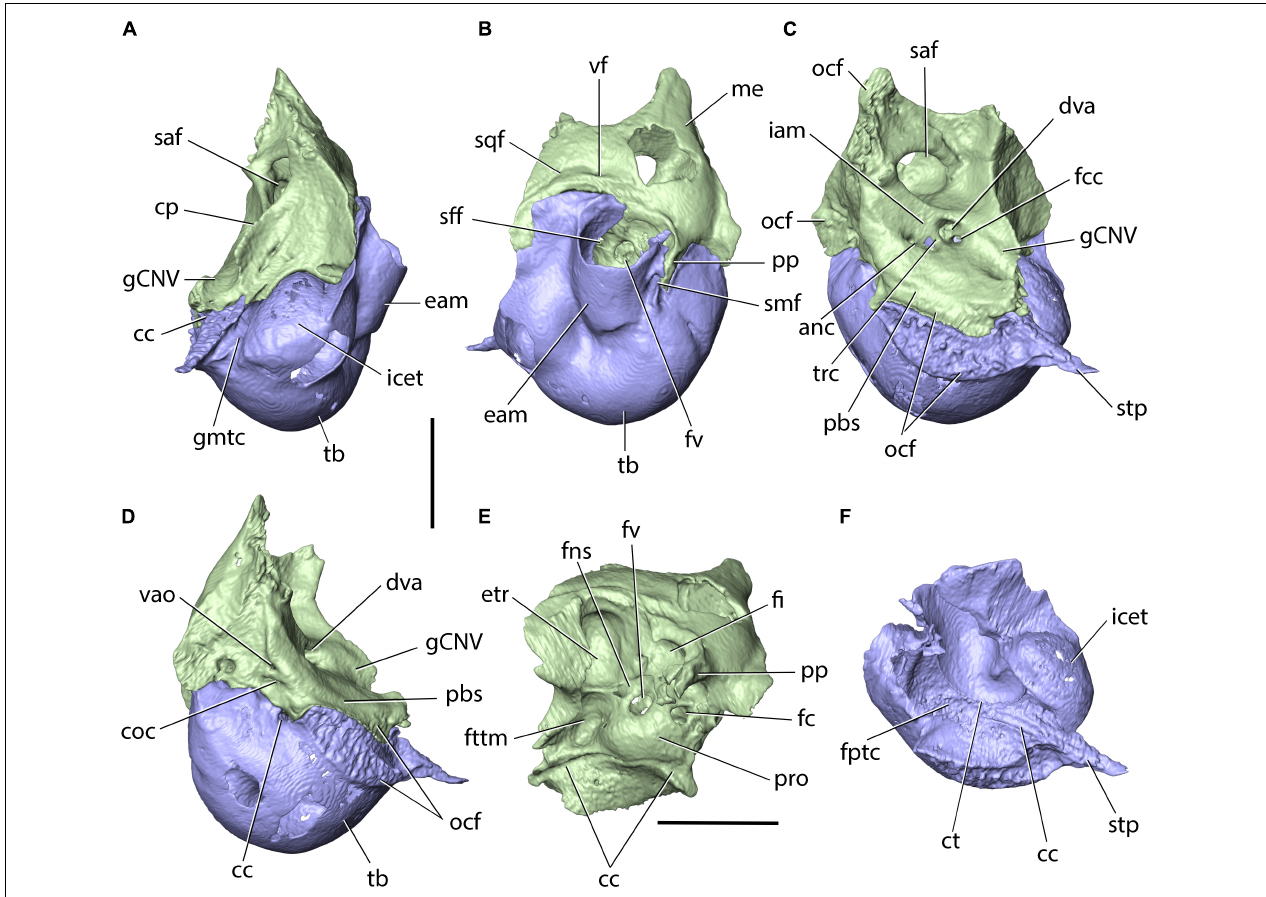
FIGURE 10 | Petrosal (light green) and ectotympanic (dark blue) of Palaeolagus haydeni (FMNH PM9476) in (A) anterior, (B) lateral, (C) medial, (D) posteromedial, (E) ventral and (F) dorsal views. anc, canal for acoustic nerve; cc, carotid canal; coc, external opening of the cochlear aqueduct; cp, crista petrosa; ct, crista tympanica; dva, dorsal vestibular area; eam, external acoustic meatus; etr, epitympanic recess; fc, fenestra cochleae; fi, fossa incudis; fns, facial nerve (CN VII) sulcus; fptc, fundic part of tympanic cavity; fttm, fossa for tensor tympani muscle; fv, fenestra vestibuli; gCNV, groove for trigeminal nerve (CN V); gmtc, groove leading into musculotubal canal; iam, internal acoustic meatus; icet, intracranial exposure of ectotympanic; me, mastoid exposure; ocf, occipital facet; pbs, petrobasilar groove; pp, paroccipital process; pro, promontory; saf, subarcuate fossa; sff, secondary facial foramen; sqf, squamosal facet; smf, stylomastoid foramen; stp, styliform process; tb, tympanic bulla; trc, transverse crest; vao, external opening of the vestibular aqueduct; vf, venous foramen. Scale bars = 5